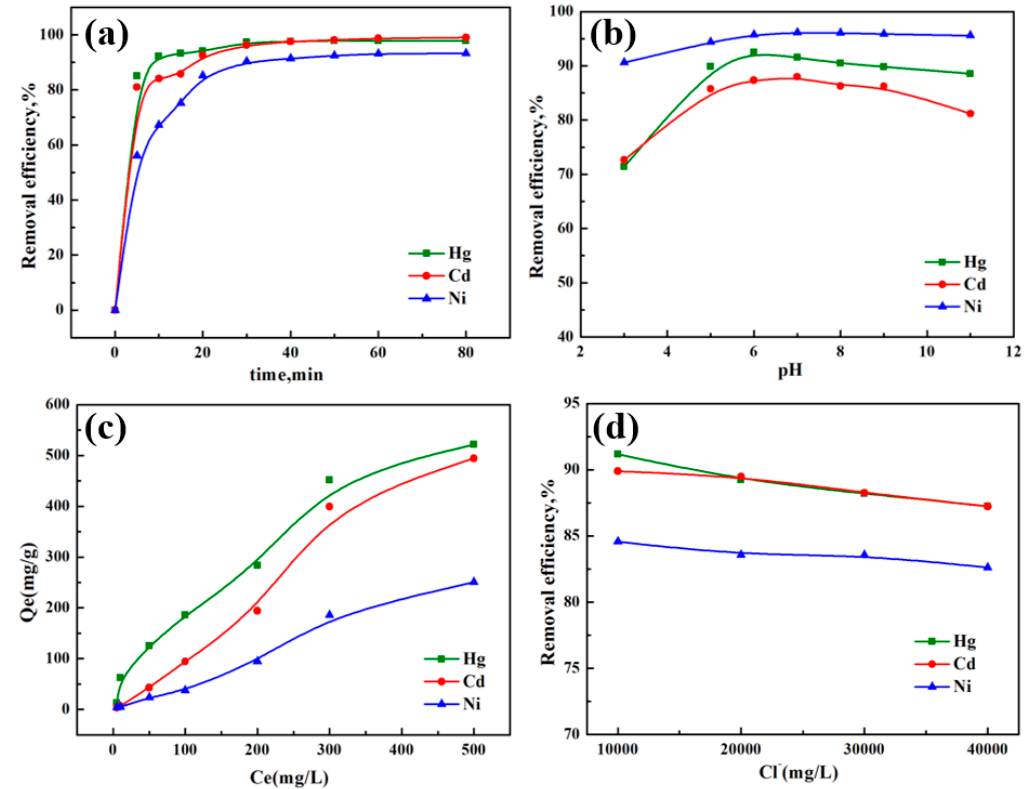
Figure 7. Parametric tests of the adsorption of heavy metals under the optimized dosage levels of Co-ACFs (Co wt % = 40%). ( a ) Effect of adsorption time; ( b ) Effect of pH; ( c ) Effect of the initial concentration of heavy metal ions in the solution; ( d ) Effect of Cl − concentration.